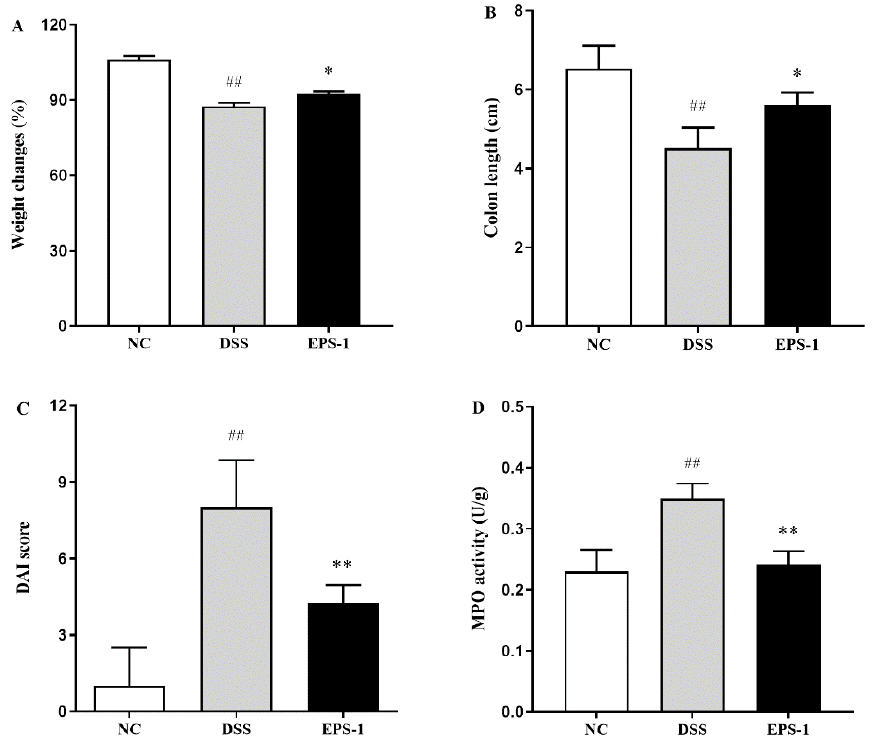
Figure 1. Effect of EPS-1 administration on DSS-induced colitis symptoms. ( A ) Changes in body weight (%), ( B ) Colon length (cm), ( C ) DAI score, and ( D ) MPO activity (U/g). Data are presented as mean ± SD. ## p < 0.01 vs. the NC group, * p < 0.05 and ** p < 0.01 vs. the DSS group by using one-way analysis of variance, followed by the Duncan’s test.